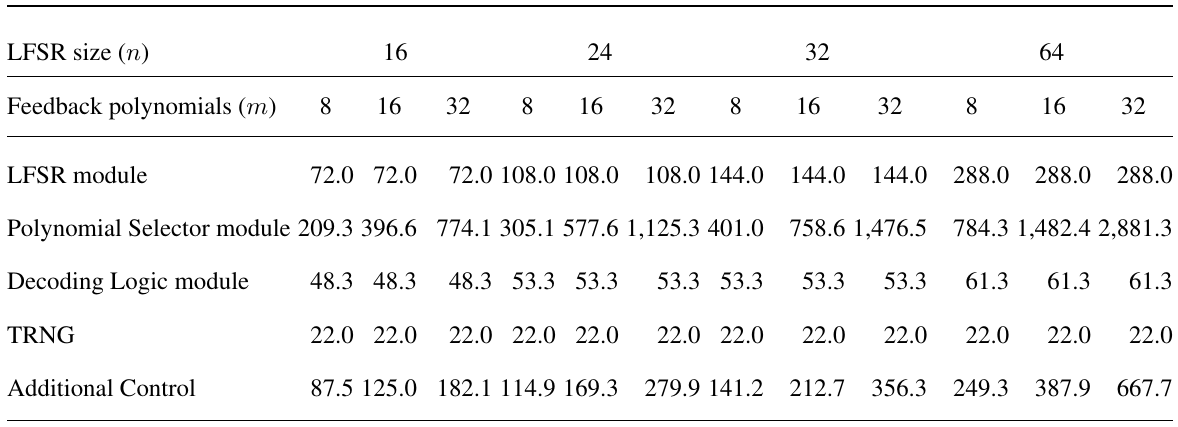
Table 1. Logical GE Count for